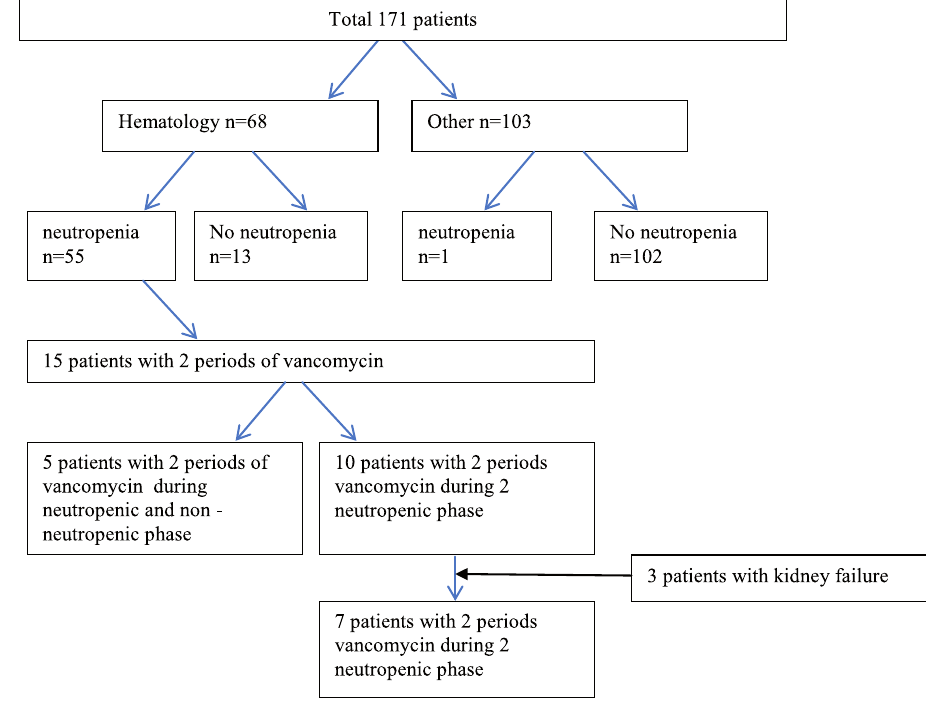
Figure 1. Flow of the 171 included patients with regard to hematology, neutropenia and two vancomycin administration periods.